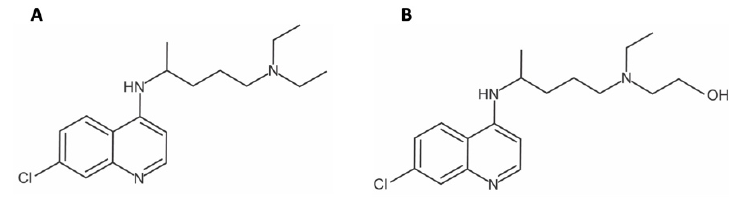
Figure 1. ( A ) Structure of Chloroquine ( B ) Structure of Hydroxychloroquine.